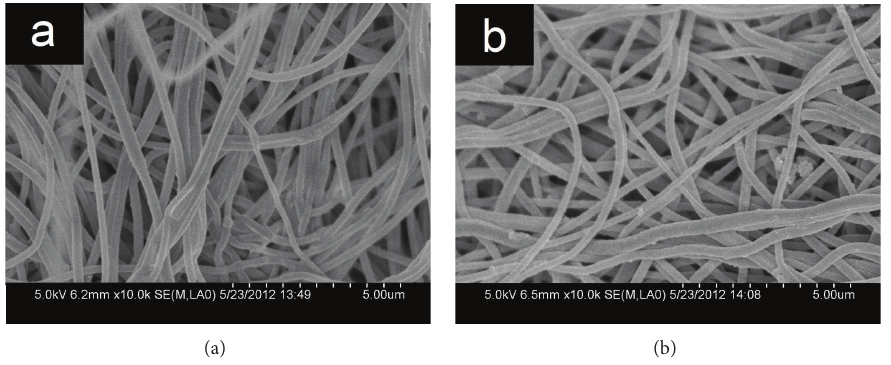
Figure 2: SEM images of (a) PAN nanofibers and (b)